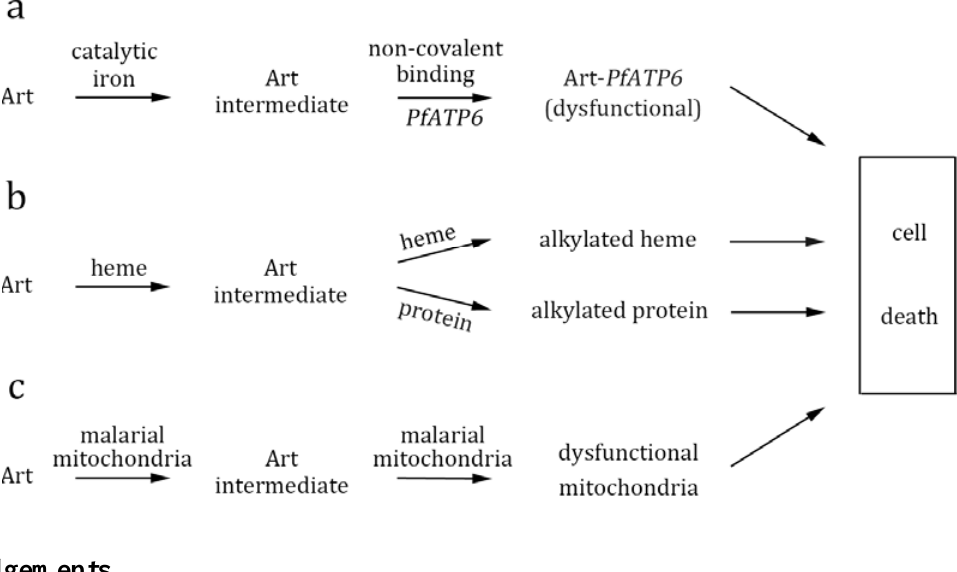
Figure 2. Proposed biological models for the action of artemisinin (Art). ( a ) The PfATP6 model: artemisinin undergoes activation by reacting with catalytic iron, and after non-covalent specific interaction with PfATP6 , the formed free radicals then exert irreversible damage to this target protein. ( b ) The heme model: artemisinin is activated by heme, followed by alkylation of heme and/or other malarial proteins. ( c ) The mitochondria model: malarial mitochondria specifically activate artemisinin. The activated artemisinin then induces free radicals production and mitochondrial membrane depolarization. No specific protein targets are